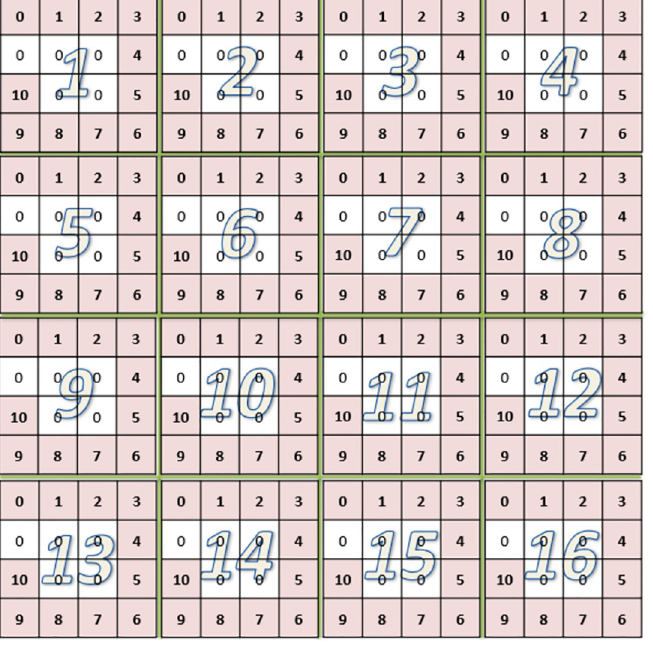
Fig 5. 16 4 × 4 data grids arranged sequentially one after another to form a Mosaic data structure as the network input to keep the time feature of the original